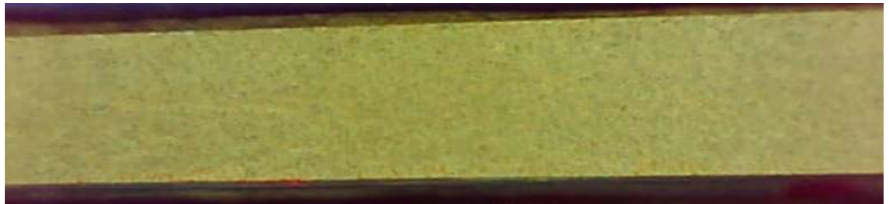
Figure 4. Cut surface of LP0.35 at the cutting speed of 4 m/min.